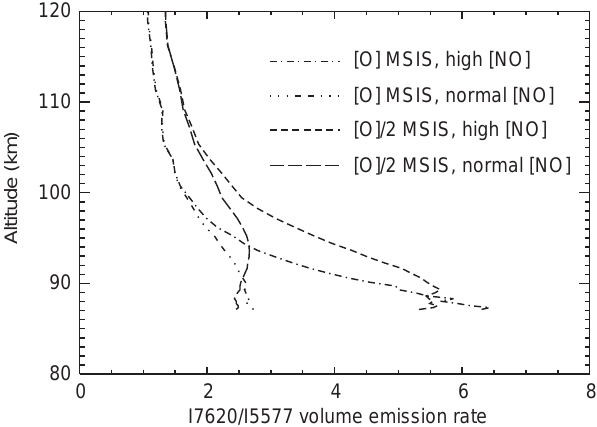
Fig. 5. Modelled (7620 A˚ )/(5577 A˚ ) emission ratios for normal and high [NO], 50 keV monoenergetic electron spectrum, and for MSIS [O] and